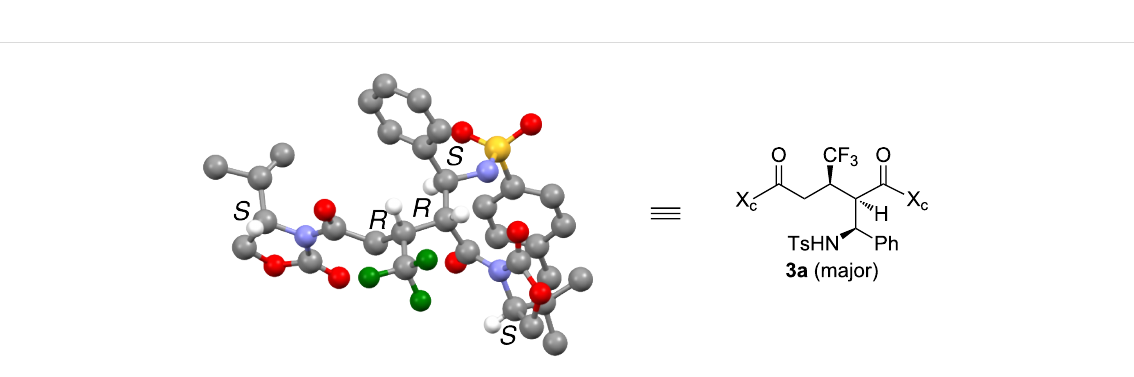
oxazolidinone-derived imides in general construct